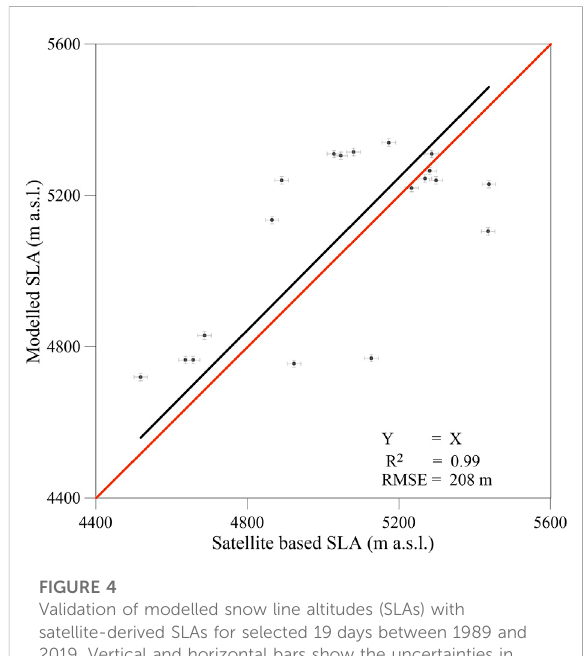
FIGURE 4 Validation of modelled snow line altitudes (SLAs) with satellite-derived SLAs for selected 19 days between 1989 and 2019. Vertical and horizontal bars show the uncertainties in modelled SLAs and satellite-derived SLAs,